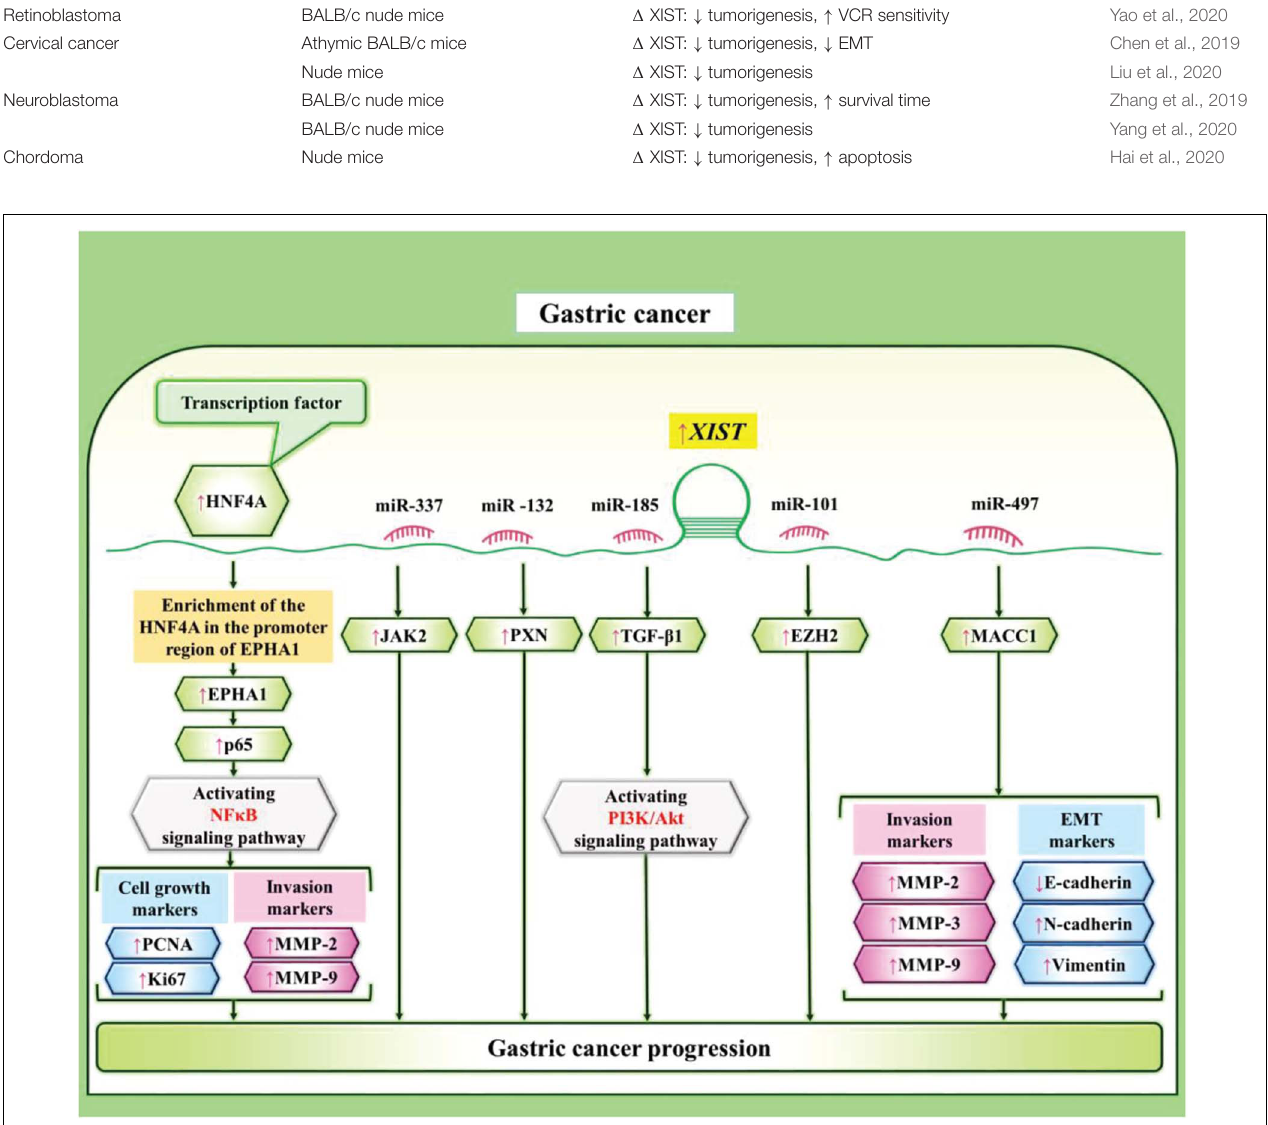
FIGURE 2 | XIST can affect gastric carcinogenesis through sponging a number of miRNAs, thus regulating NF- κ B and PI3K/AKT pathways (Chen et al., 2016; Lu et al., 2017; Ma et al., 2017; Zhang et al., 2018; Li et al., 2020a; Zheng et al., 2020).